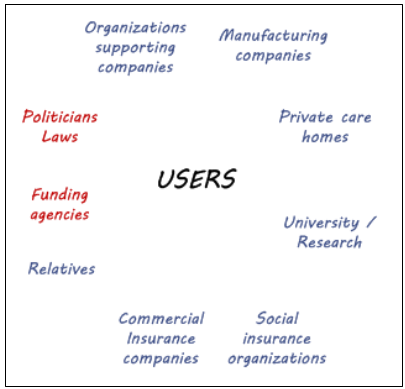
Figure 8. Overview of the players developed in workshop 1.